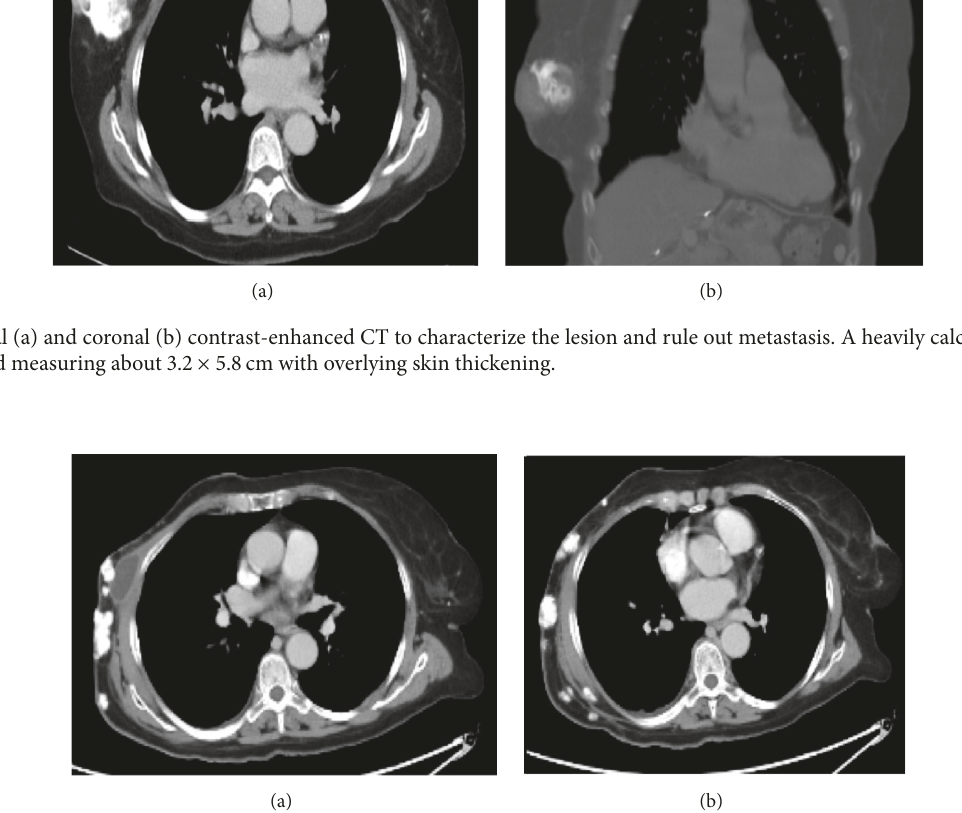
Figure 5: Axial contrast-enhanced postoperative CT performed after three months demonstrates postoperative changes including seroma and multiple right chest wall subcutaneous calcified nodules compatible with